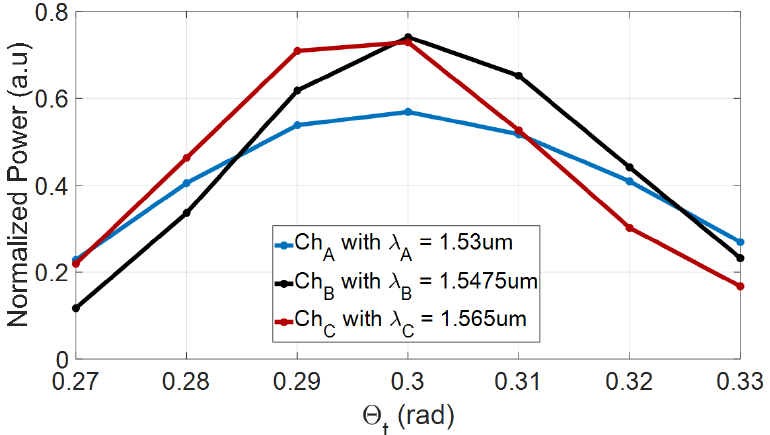
θ t for the operating